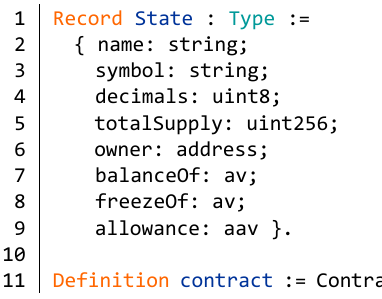
Figure 14. The state model of the Binance Coin (BNB) contract.